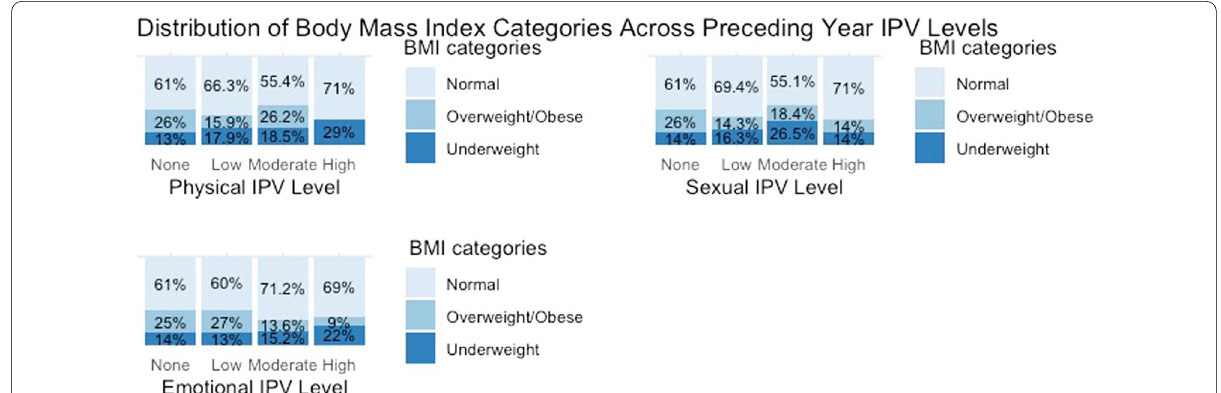
Fig. 1 Distribution of BMI categories across preceding year IPV Intensity Levels